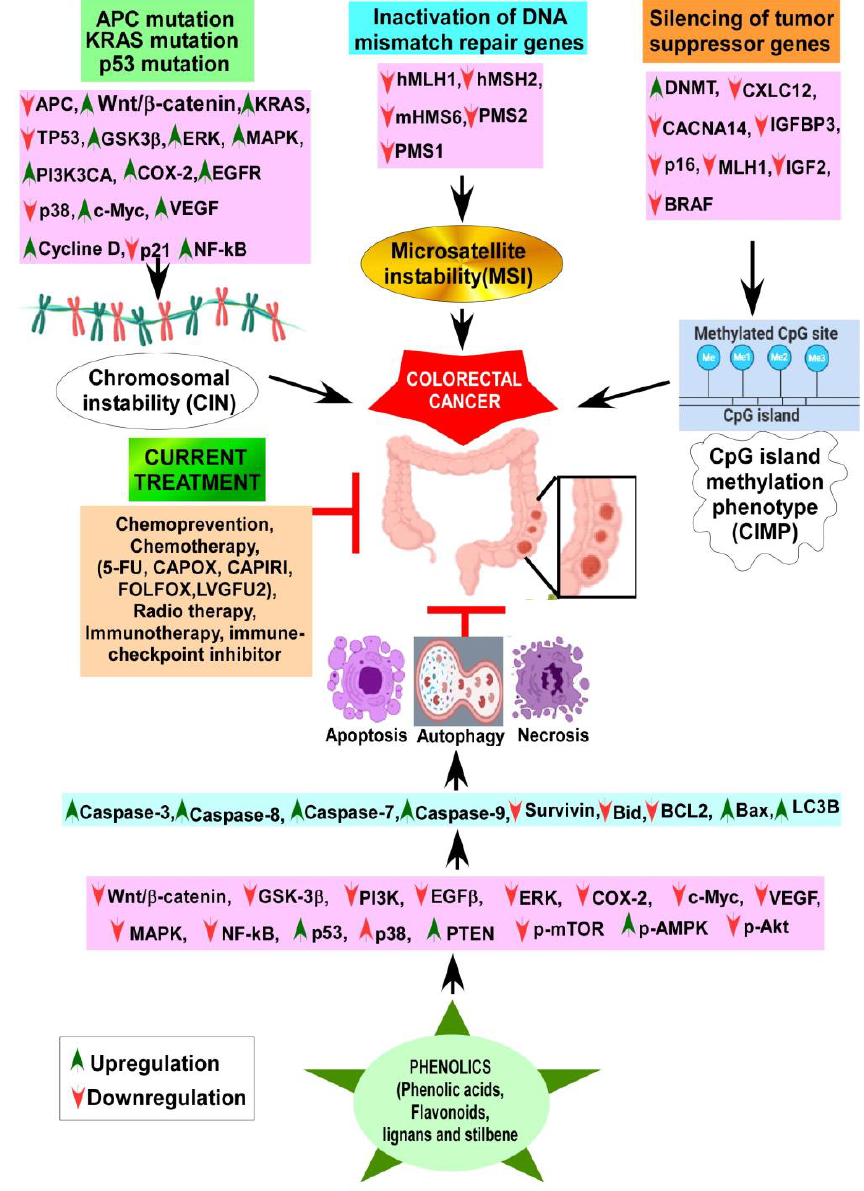
Figure 6. Genetic and molecular basis of colorectal cancer along with the current treatment strategies where potentials of phenolic compounds were indicated. CIN, MSI and CIMP are the prime factors in CRC development. Besides the currently available chemotherapeutic treatment strategies, different polyphenols are reported to induce CRC cell death by apoptosis and/or autophagy and/or necrosis.